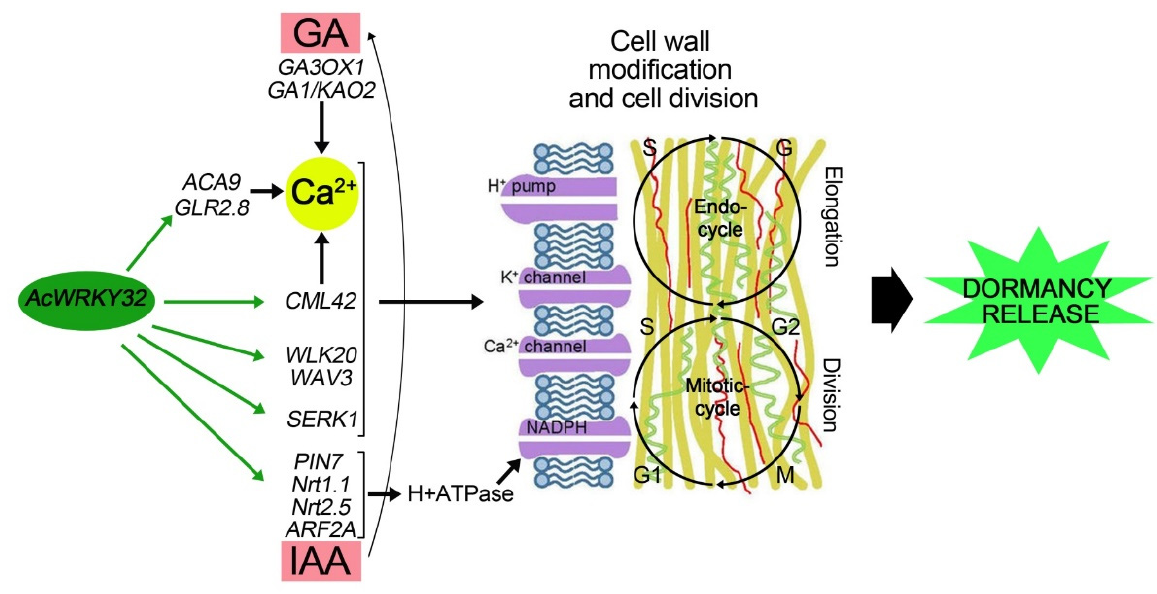
Figure 6. An overview of the proposed model explaining AcWRKY32 and its co-expression gene network role in the onion bulb dormancy release. The model underlines the triggering role of the TF for driving cell wall modification and division through gibberellin and auxin homeostasis, two key processes involved in the dormancy release. The green arrows indicate the triggering action of AcWRKY32 to its co-expressed genes. The black arrows underline the pathway steps determining the dormancy release previously described. The pink rectangles highlight the two crucial hormones (IAA and GAs) related to dormancy breakage, while the yellow circle underlines the key molecule (calcium) involved in the cell wall modification (elongation and expansion) and cell division. Differentially expressed genes putatively involved in dormancy breakage and interacting with AcWRKY32 are reported in black.